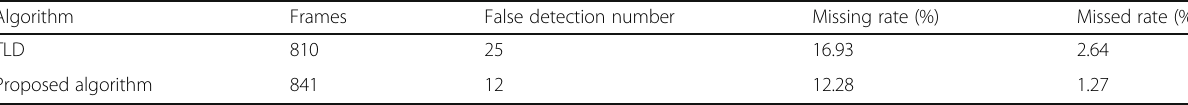
Table 3 The comparison of false rate and missing rate on the car video